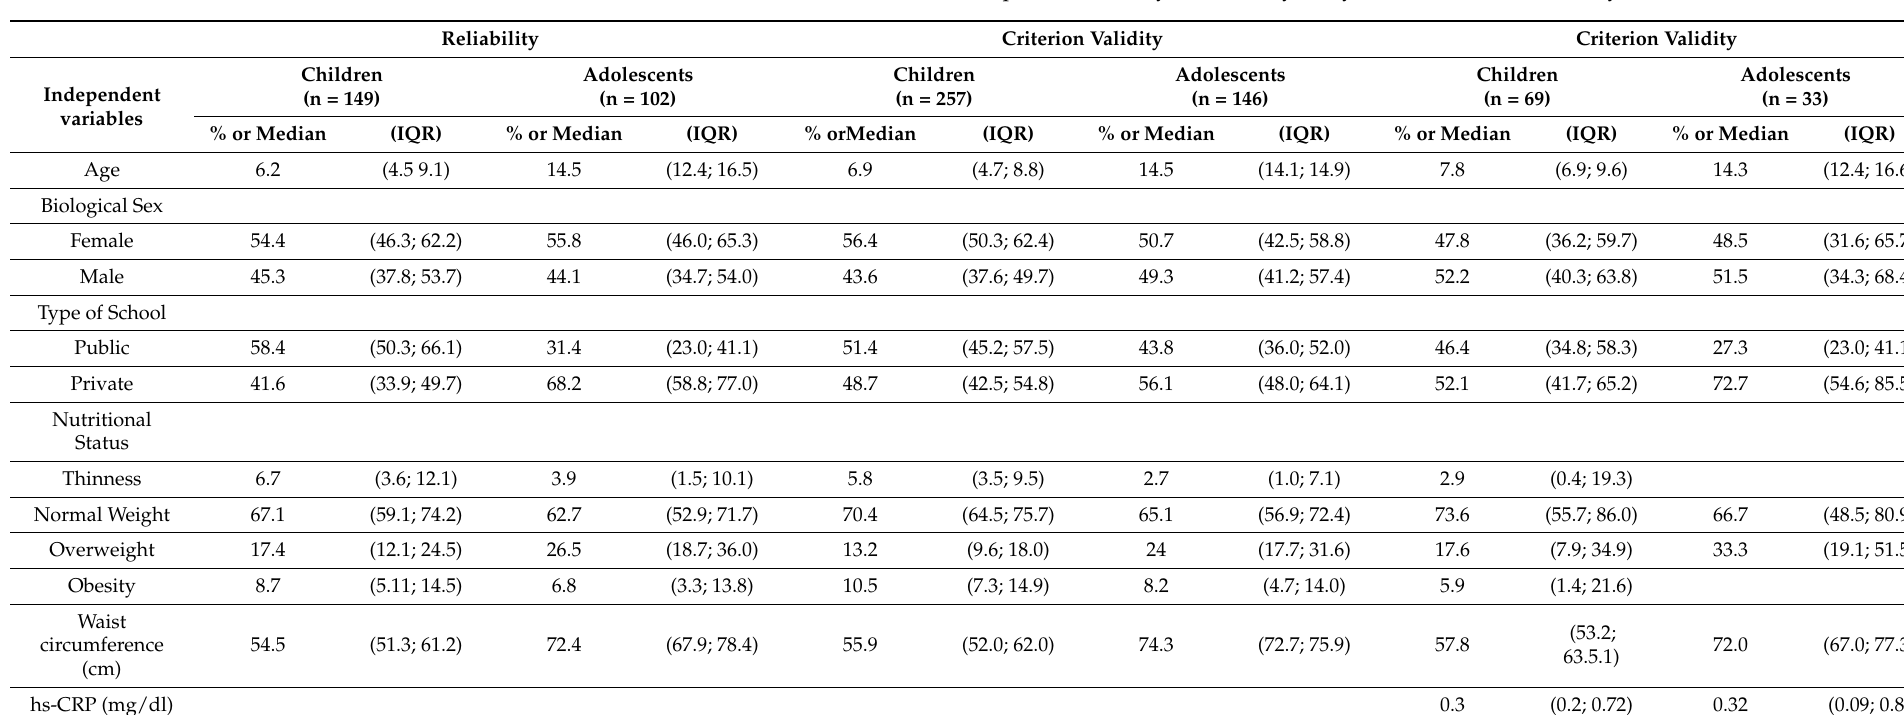
Table 2. Characteristics of children and adolescents from a sub-sample for reliability and validity analyses of the SAYCARE Study.